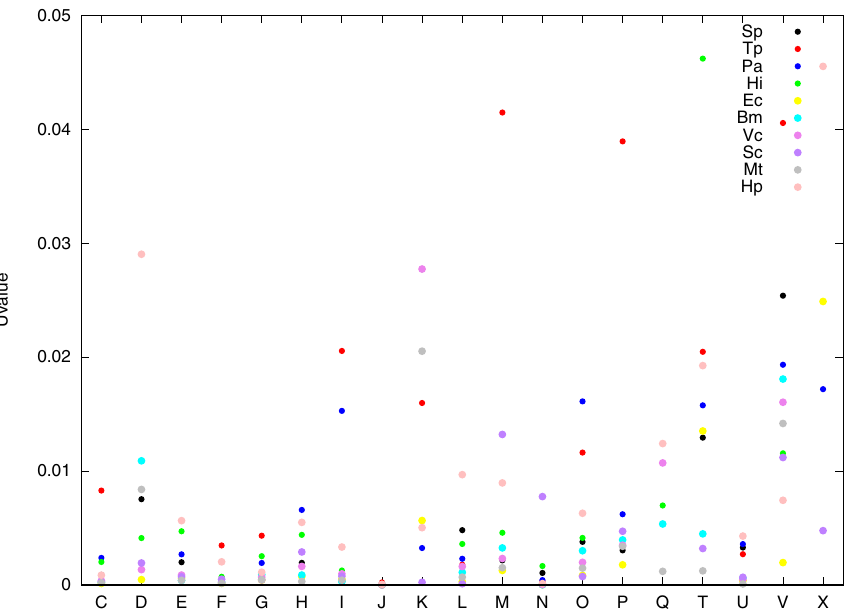
Figure 8. Diagonal entries of U -value arrays. The x -axis is labelled by functional classes and each color represents a different organism as indicated in the top right legend of the